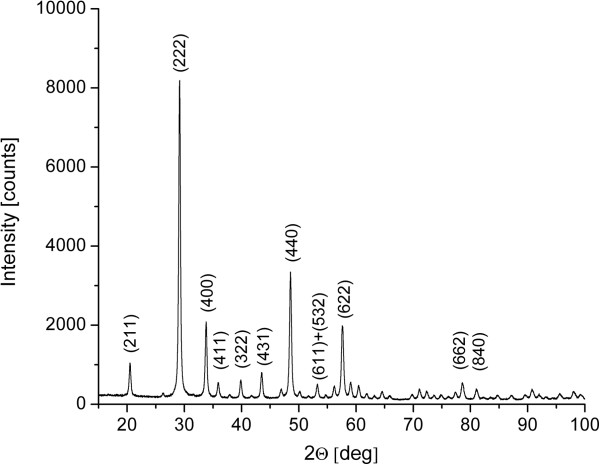
XRD pattern of Y1.97Yb0.02Er0.01O3 UCNPs. Diffraction peaks are indexed according to PDF card #87-2368 (cubic bixbyite Y2O3 crystal structure).